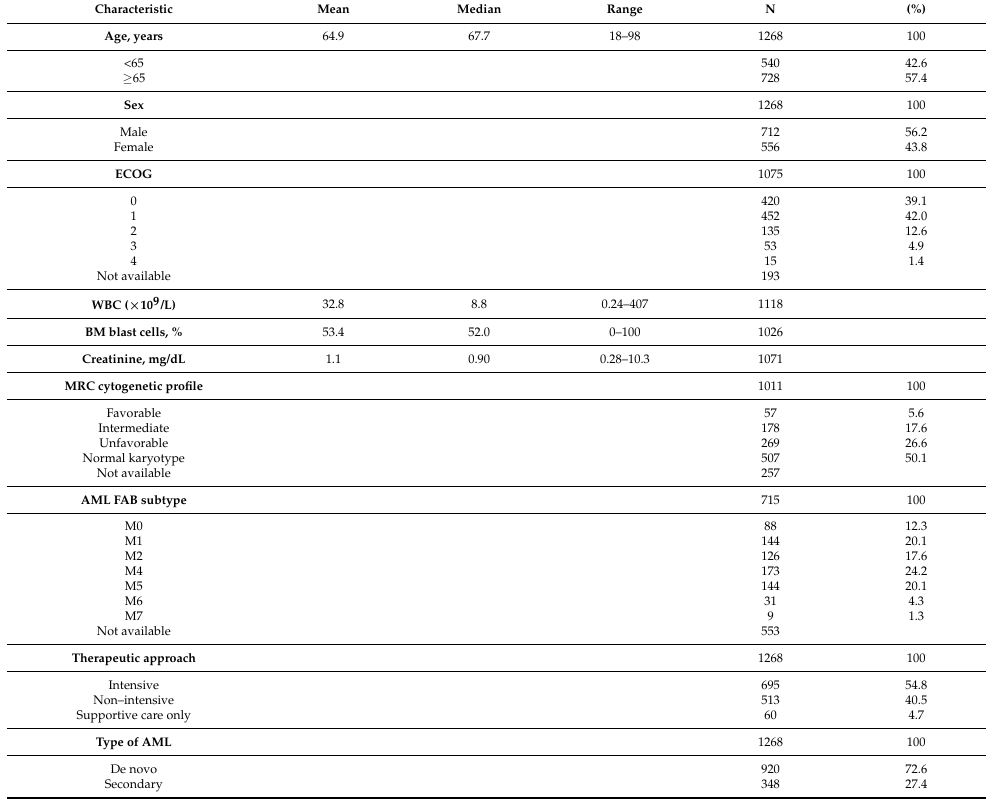
Table 1. Diagnosis cohort (N = 1268). Demographic and baseline